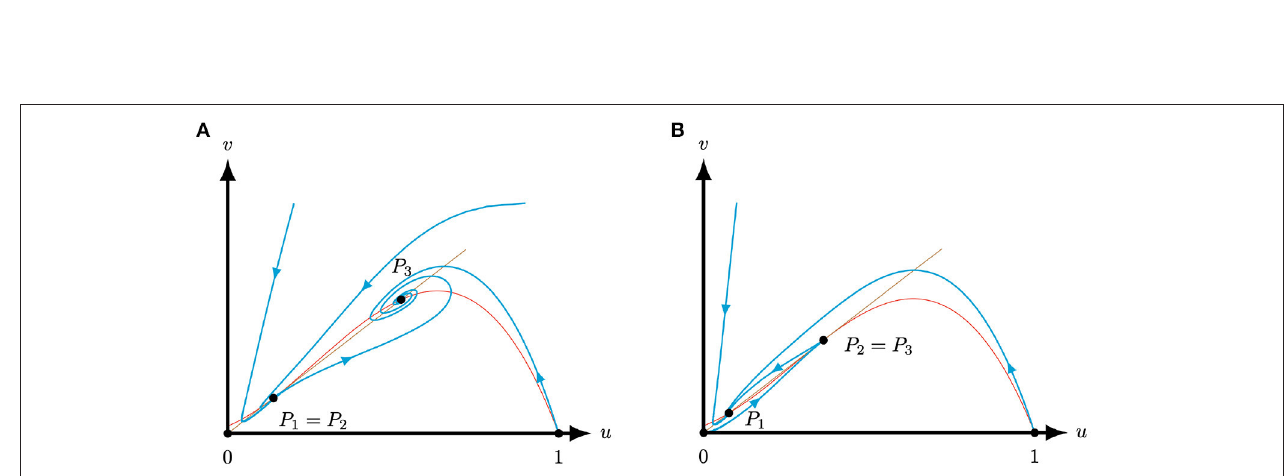
0.1, M 0.1 and Q 0.363, such that system (4) has three positive equilibria P , for varying S (Corollary 3.3). The = = − = 0.13 the equilibria P 1,3 are repellers. The equilibria are surrounded by a stable limit cycle. =